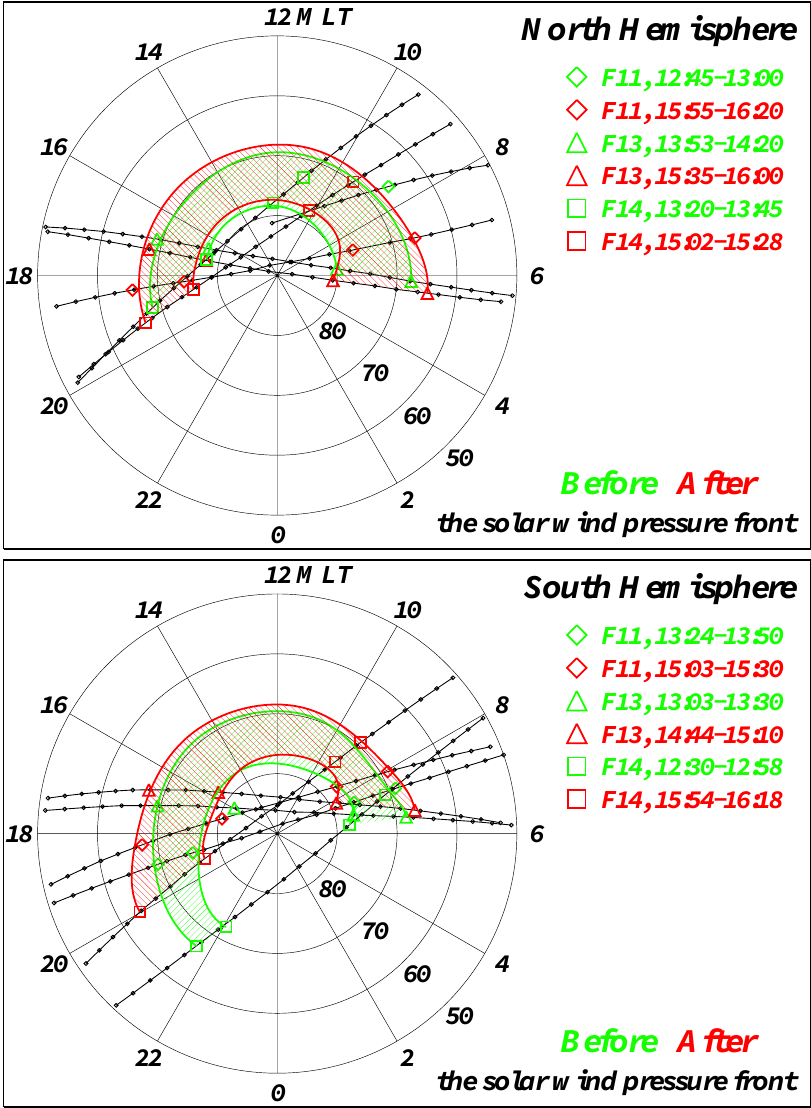
Fig. 3. The same as in Fig. 1 for 6 January 1998, North Hemisphere on the top and South Hemispere on the bottom. The various symbols denoting the boundary crossings by different spacecraft are explained at the legend on the right. No poleward motion of the dayside oval is